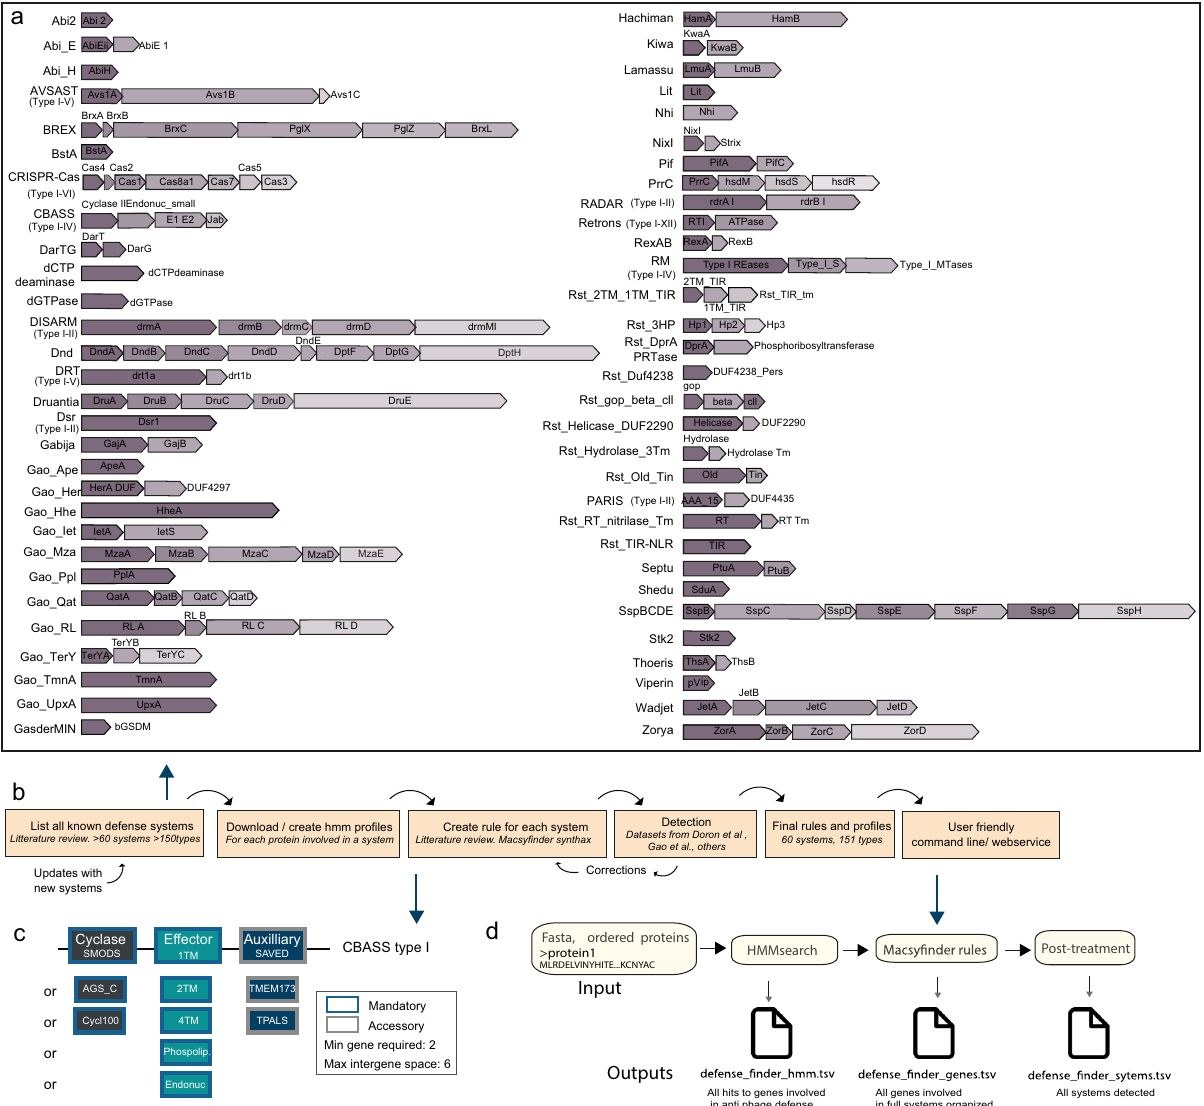
Fig. 1 DefenseFinder, a tool to detect all known prokaryotic antiviral systems. a List of systems included in DefenseFinder. Systems are ordered alphabetically. For systems with several types, each system is represented by one type and other types are indicated in parentheses (Full list, Supplementary Data Table 1). b Work fl ow for the creation of DefenseFinder. c Example of a DefenseFinder rule (in the MacsyFinder syntax) for the detection of system CBASS type I. Cyclase and effector proteins are mandatory while the sensing protein is only accessory. This means the system allows for it to be missing in a detected CBASS type I system. Different pro fi les are recognized for a protein. ex cyclase (SMODS, AGC_C, Cycl100). d DefenseFinder function layout. DefenseFinder takes an ordered multifasta protein fi le. A search for speci fi c HMM pro fi les is conducted, the MacSy fi nder rules speci fi c for antiviral systems are applied on the search results, generating three results fi les.